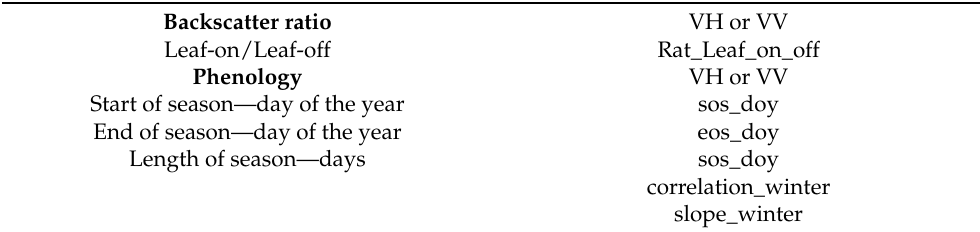
Table 3. Summary of the Sentinel-1 phenological parameters of the 2018 vegetation period used for